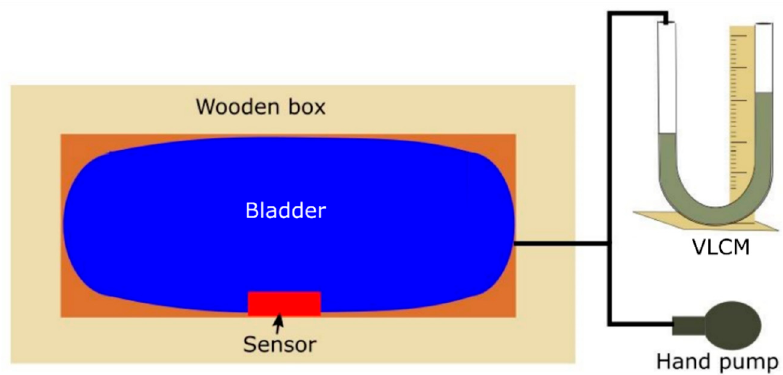
Figure 3. Schematic diagram for the experimental setup for validation of sensor readings against the vertical liquid column manometer (VLCM).